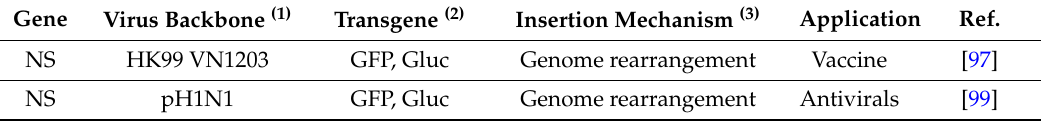
Figure 6. Reporter influenza A viruses with genome rearrangement: Schematic representation of mutant NS ( A ) and PB1 ( B ) viral segments as described in Figure 1. ( A ) Bicistronic transcription of NS1 and reporter gene: A splice acceptor mutation (SAM; *) inhibits alternative splicing. Reporter protein expression occurs after 2A cleavage; ( B ) Bicistronic transcription of PB1 and NEP: Expression of PB1 and NEP gene products occurs by insertion of the 2A autocleavage site sequence. PB1 3’ packaging signals were duplicated after the NEP ORF and before the 3’ NCR terminus. Table 6. Reporter-expressing recombinant influenza A viruses with a rearranged genome.